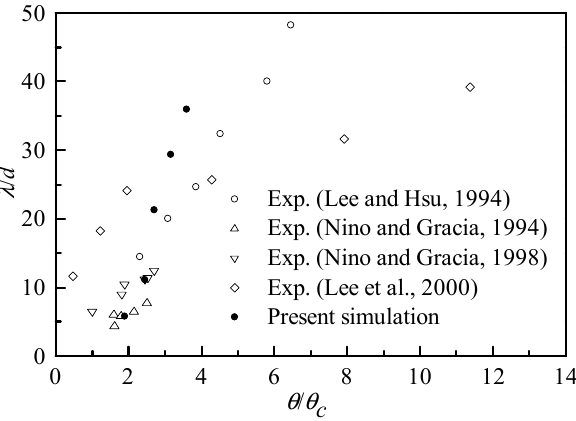
Figure 11. Dimensionless saltation length with transport stage [8,9,12,18]. Figure 12 presents a comparison of the dimensionless saltation height between the present simulated results and the experimental results. It is found that the dimensionless saltation height increases with the increase of the transport stage. At the low transport stage, the dimensionless saltation height is in good agreement with the experimental results by Niño and García [9,17]. Similar to the saltation length, the difference of saltation height between the present simulated results and experimental results at the medium transport stage may be induced by the inter-particle collision, particle size, and flow depth. Moreover, Auel et al. [61] indicated that for a given transport stage, the saltation height for a mild bed slope is larger than that for a steep slope, and the differences reduce with the increase of the transport stage. 100.00.51.01.52.02.53.0 Exp.(Lee and Hsu, 1994)